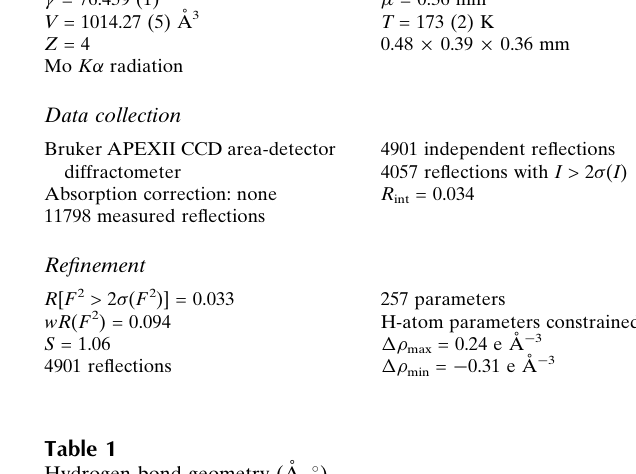
Hydrogen-bond geometry (A˚ , (cid:3)